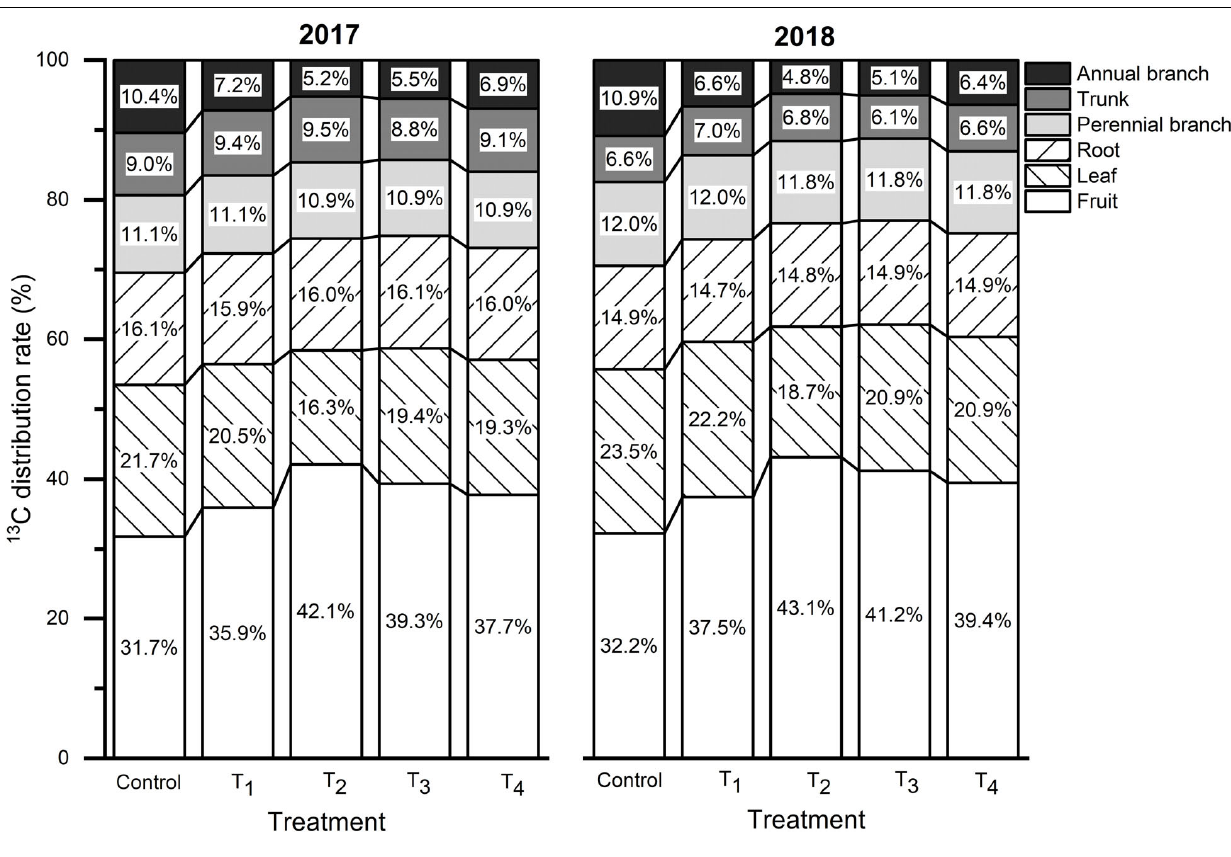
FIGURE 7 | Effects of DMPP on the 13 C distribution rate at the fruit maturity stage in 2017 and 2018 ( 13 C distribution rate refers to the ratio of the 13 C content of each organ to the amount of net 13 C absorbed by the